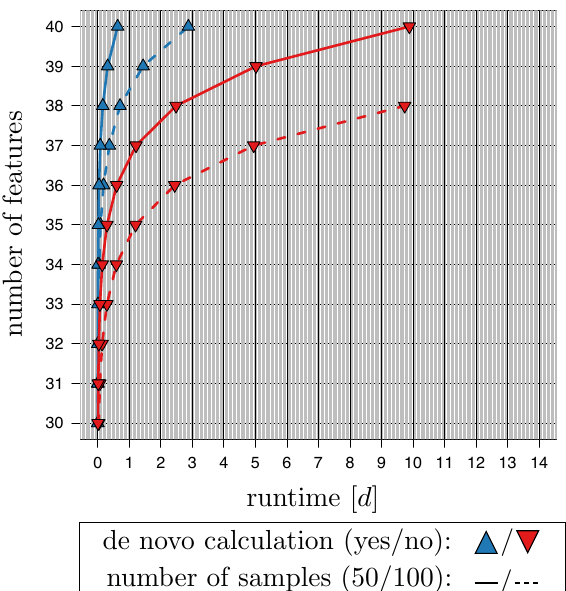
Figure 4. Runtime of exhaustive distance calculations. The figure summarizes runtime experiments on artificial datasets with n ∈ { 30, . . . , 40 } features (100 cores). In each experiment, the distance matrices of all 2 n − 1 feature combinations are generated. A maximal runtime limit of 14 days ( ≈ 1.21 · 10 9 ms) was used. A comparison of a de novo calculation (lower-red triangle) and the proposed traversal strategy (upper-blue triangle) on datasets with m ∈ { 50, 100 } samples is